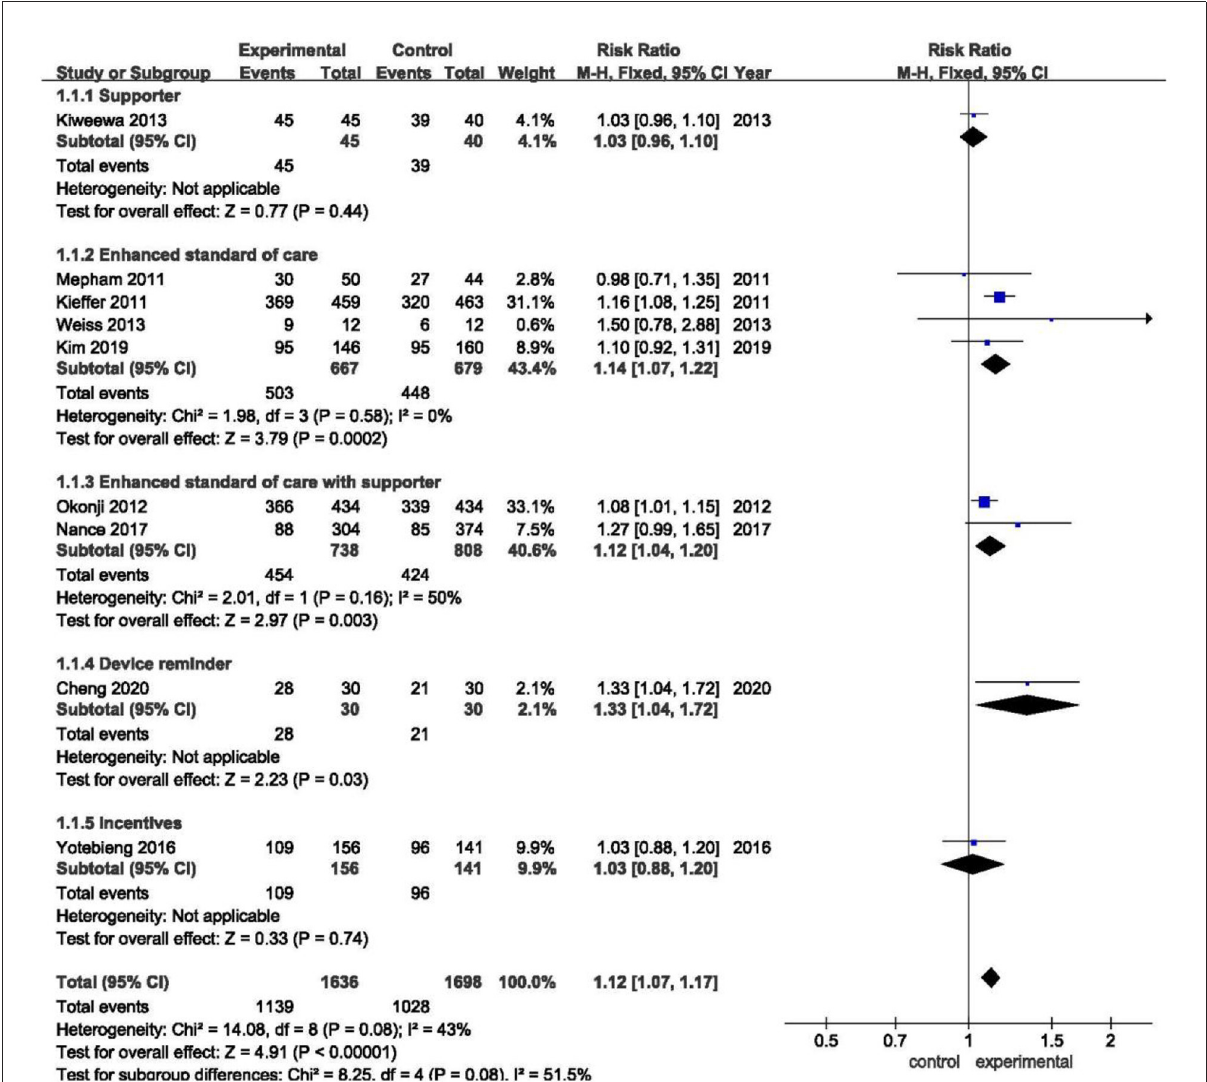
FIGURE2 Overall forest plot showing the impact of different improvement approaches to medication adherence.